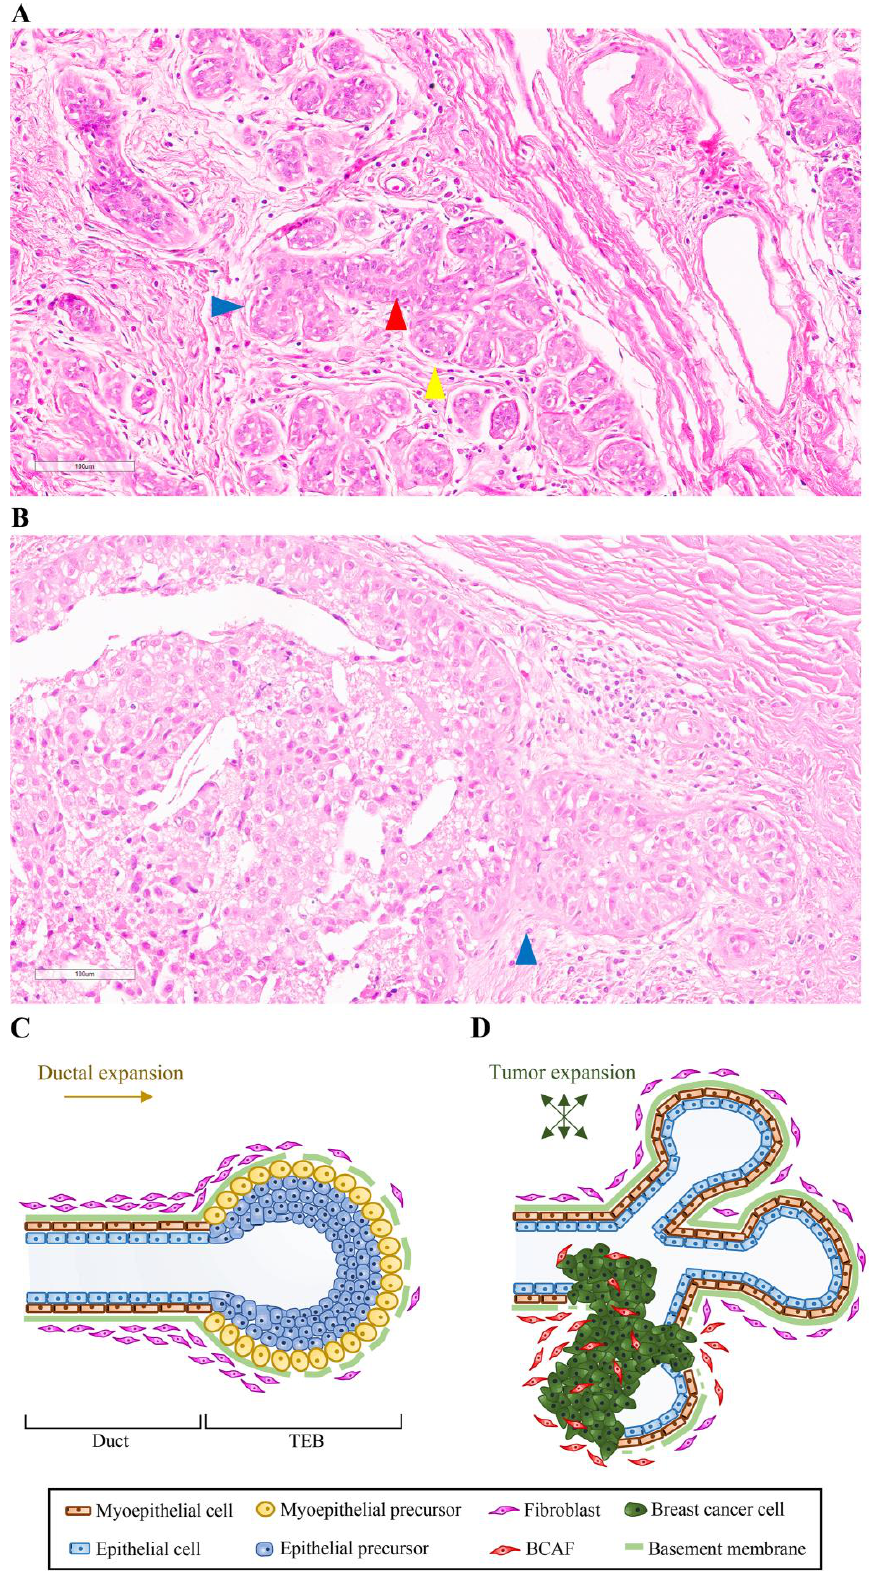
Figure 1. ( A,B ) Haematoxylin and eosin staining. ( A ) Normal structure of human terminal duct lobular units (TDLUs), composed of an inner layer of luminal epithelial cells (red arrow), and an outer layer of myoepithelial cell (yellow arrow), separated from the stroma by a basement membrane (blue